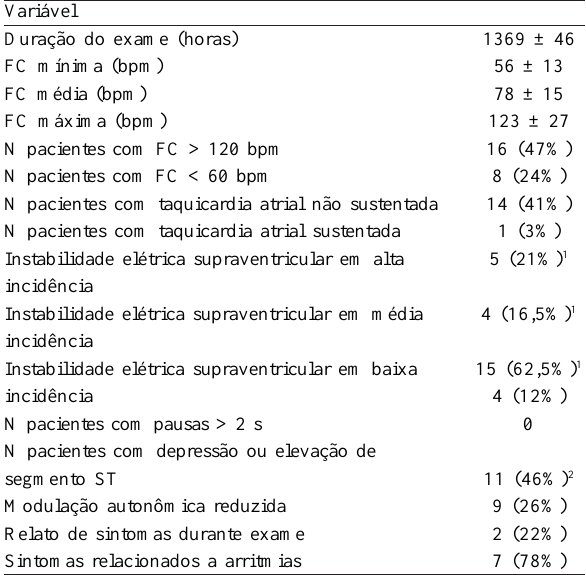
Tabela 1. Variáveis analisadas pelo Holter